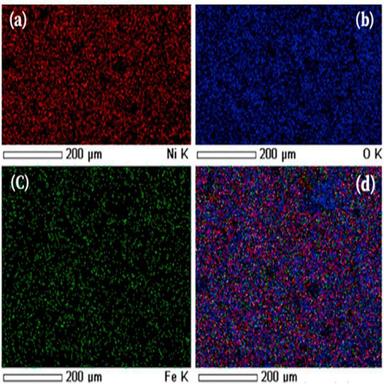
SEM elemental mapping for Ni (a),O (b),Fe(c) and Fe: NiO 2.5% doped films(d).